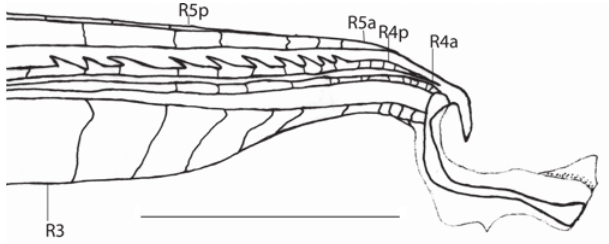
Fig. 37. Gonopodium tip of Phalloceros megapolos , MCP 13735. R3, R4a, R4p, R5a, R5p indicate gonopodial rays. Scale bar 1